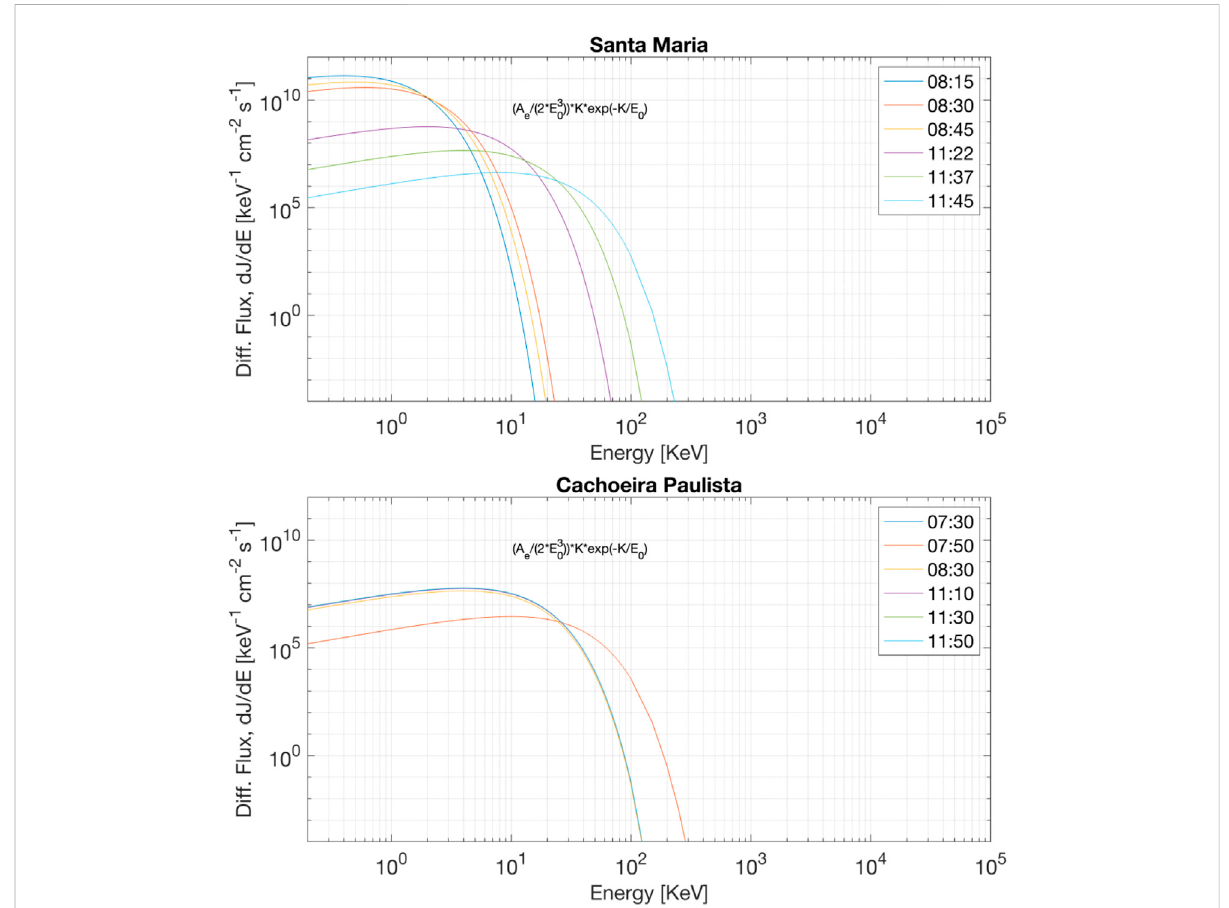
FIGURE 10 Total incident energy of electrons (100 eV — hundreds of keV) for Santa Maria (top) and Cachoeira Paulista (bottom) stations, considering the second and third conjunctions. The height scale H (km) is calculated to Santa Maria and Cachoeira Paulista during the three conjunctions (See Figure